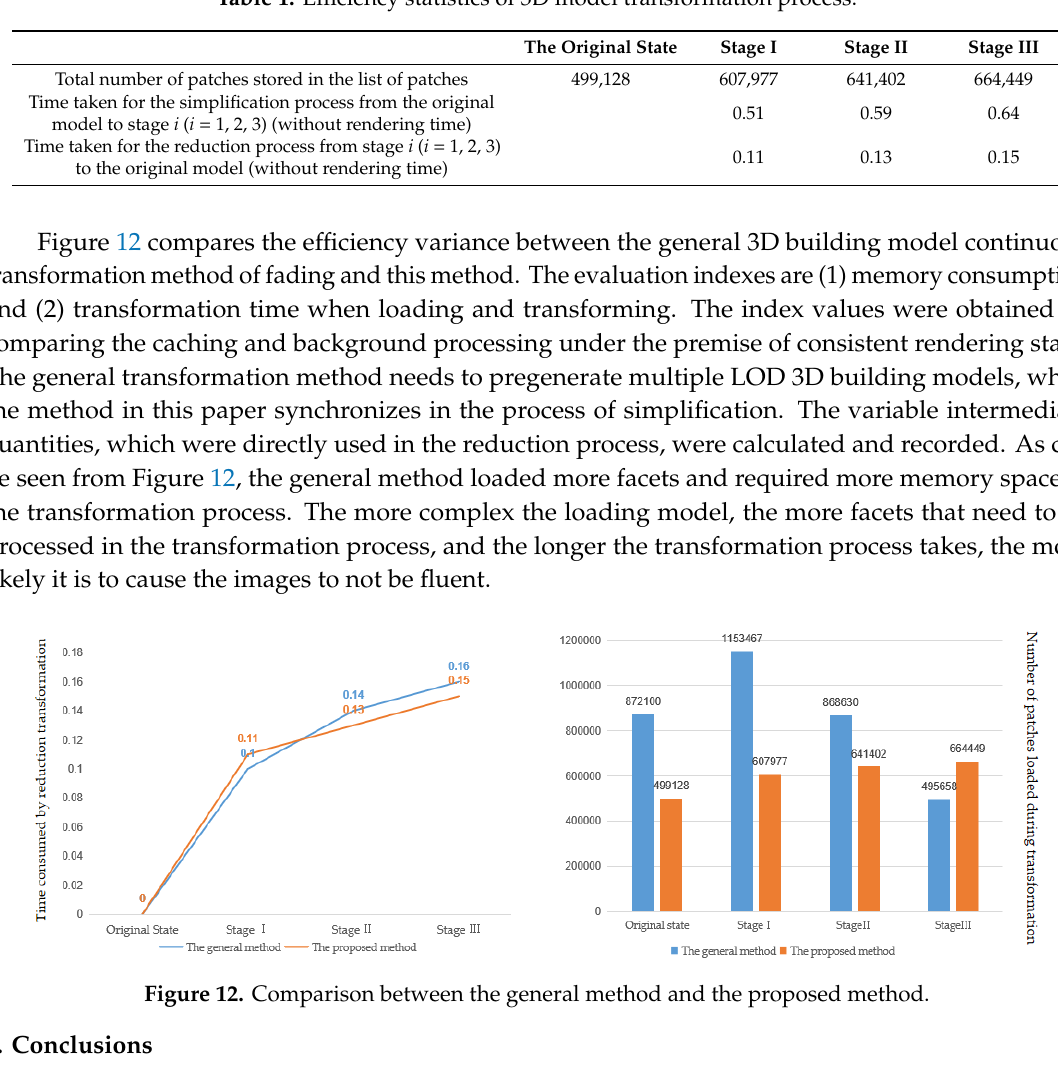
Table 1. E ffi ciency statistics of 3D model transformation process.